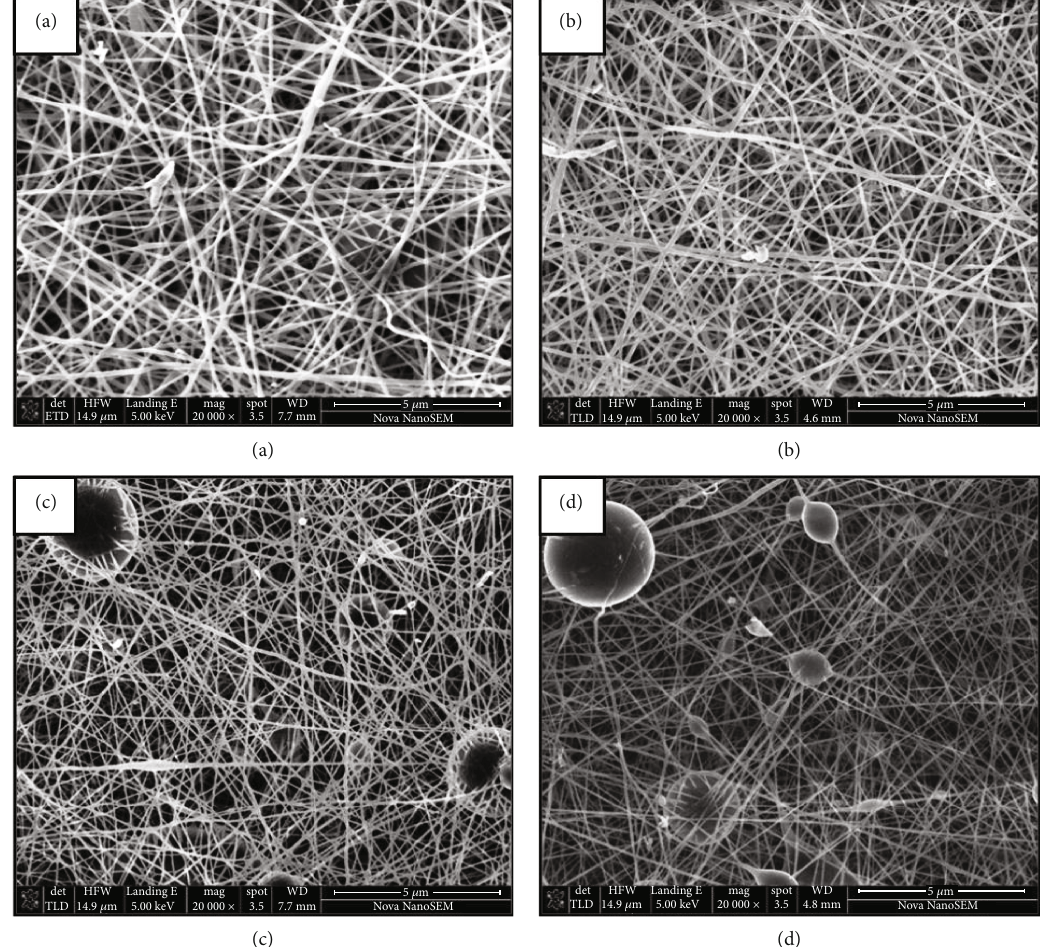
Figure 4: SEM images of electrospun nano fi bers prepared with di ff erent weight ratios of (a) 20/80, (b) 30/70, (c) 40/60, and (d) 50/50 of CS/PVA at a voltage of 15kV and a distance of 15cm.